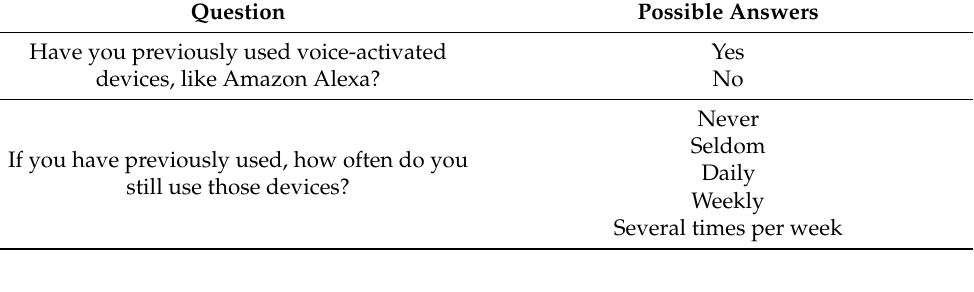
Figure 10. Obtained statistical data for the first question in the initial survey. Table 2. Age distribution of the users.